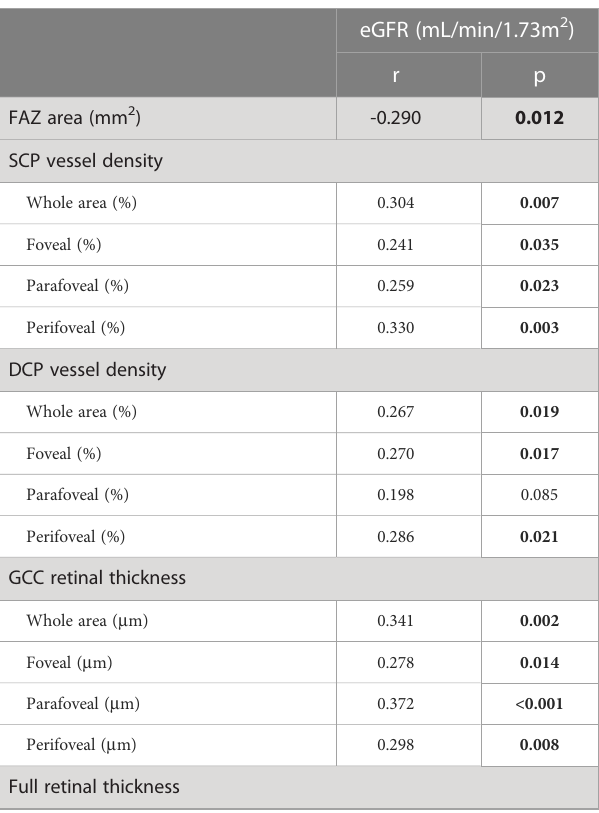
TABLE 5 Correlation analysis between estimated glomerular fi ltration rate (eGFR) and optical coherence tomography angiography parameters in all